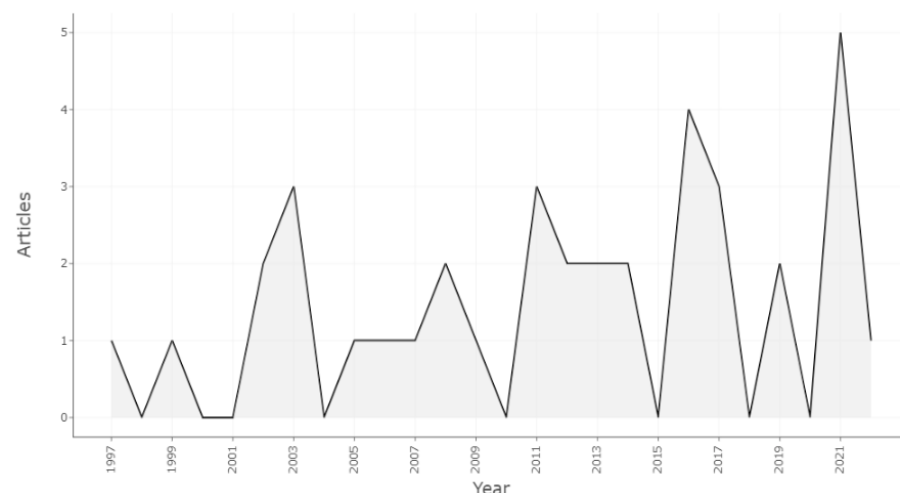
Figure 2. Annual scientific production.